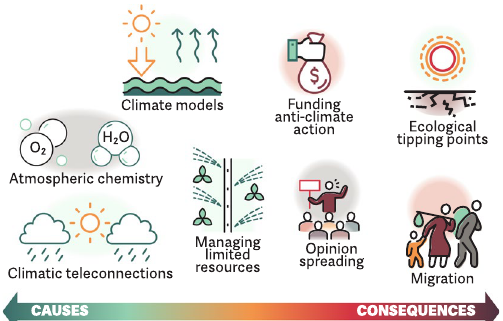
Fig. 1 Overview of topics related to climate change that have been studied by networks. Most topics in the science of climate change are causally coupled. Still, in the discourse, some have more the flavor of causes, some are more